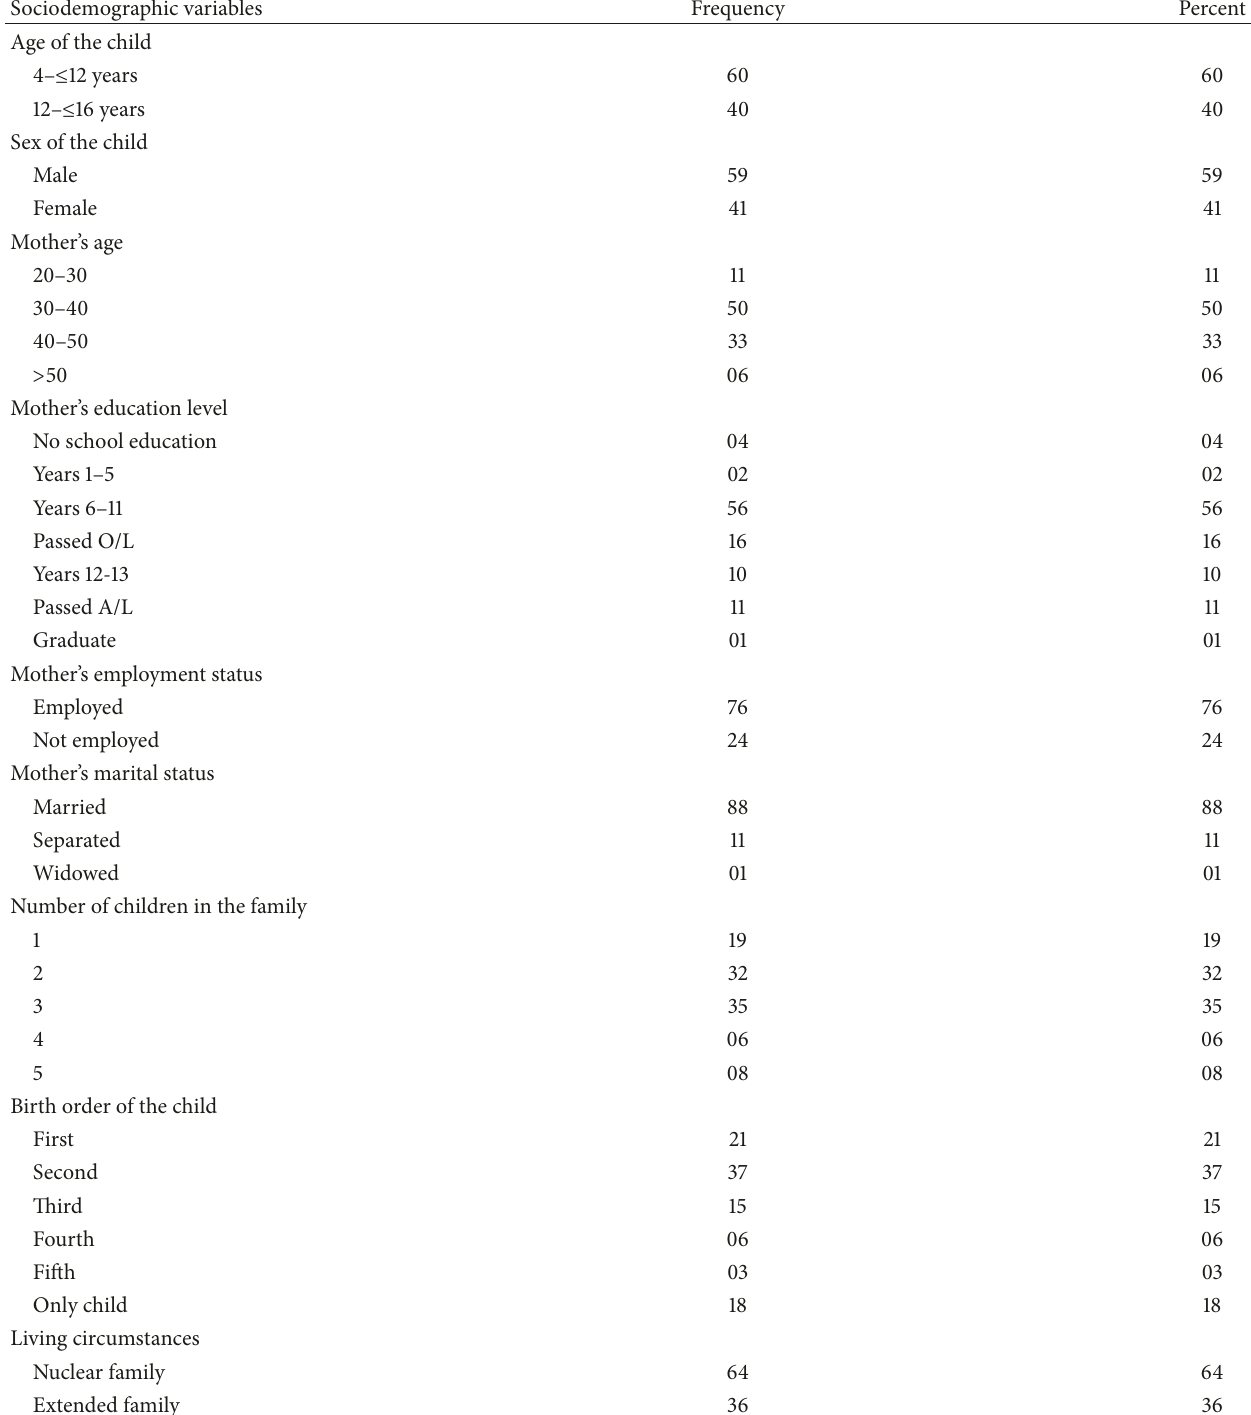
Table 1: Sociodemographic characteristics (study sample: 𝑁 = 100 and the age: 4–16